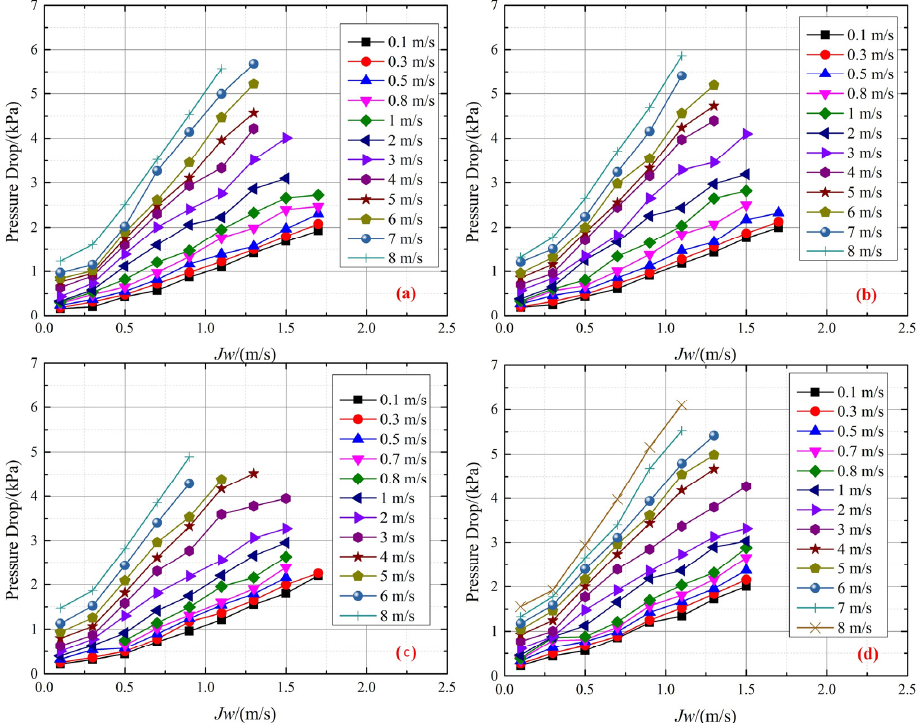
Figure 7. Effect of flow velocity on the ∆ P f ( A = 62 mm): ( a ) H = 0.5 Hz, ( b ) H = 0.8 Hz, ( c ) H = 0.9 Hz, ( d ) H = 1.0 Hz.